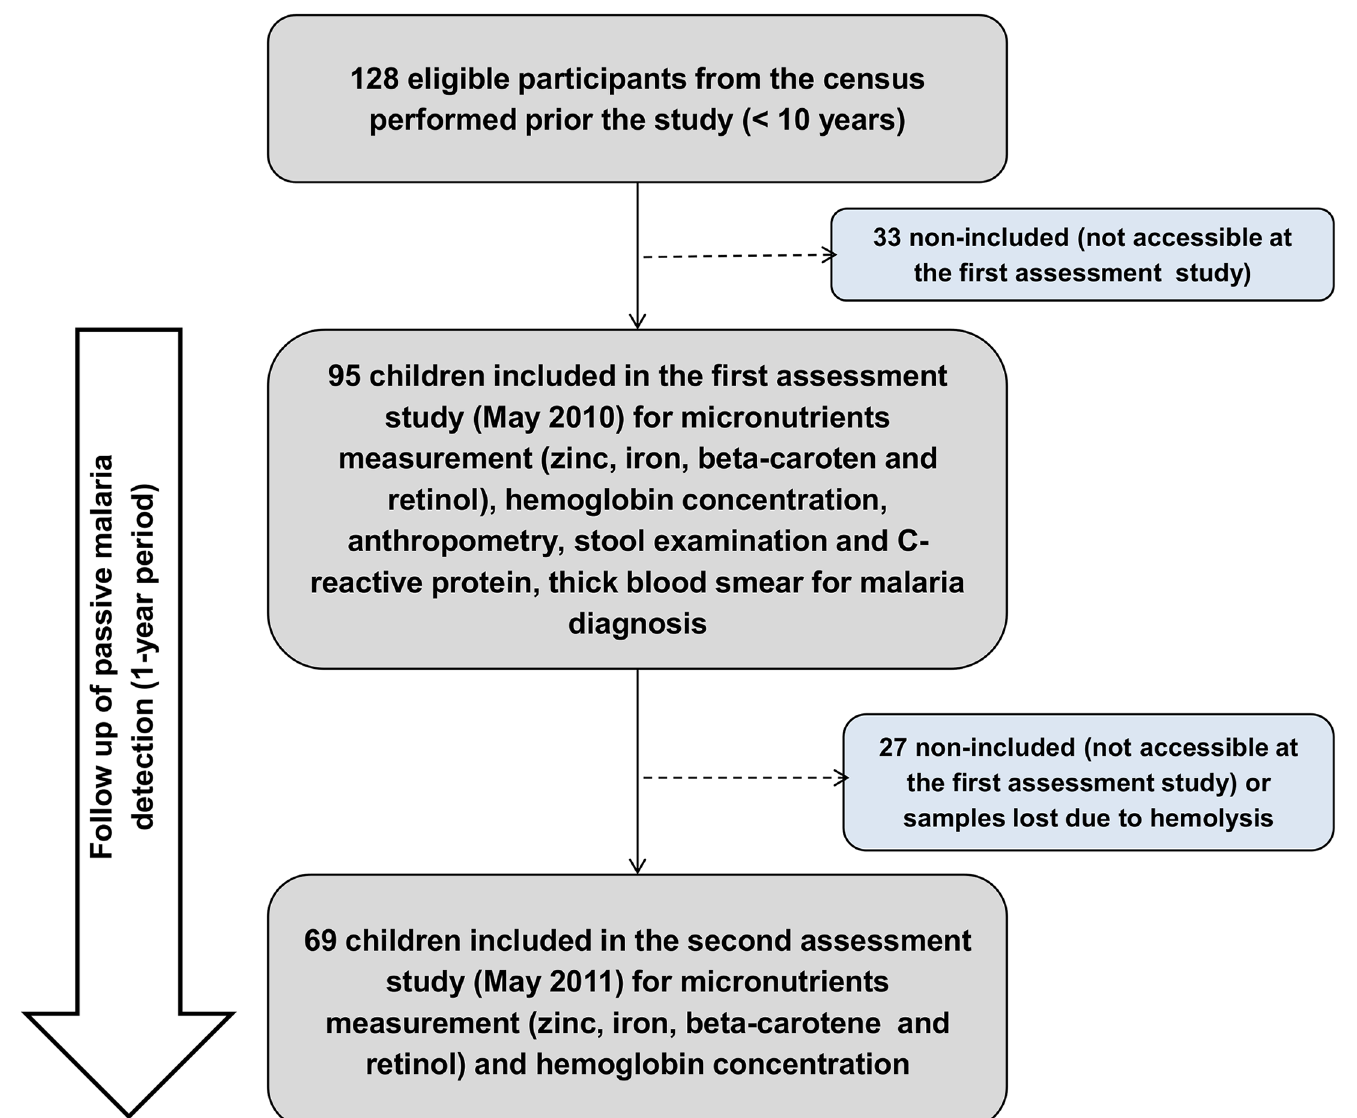
Fig 1. Study flow chart. From 128 eligible participants from the 2008 census, 95 children were included in the baseline assessment (2010) and 69 completed the follow up (2011).